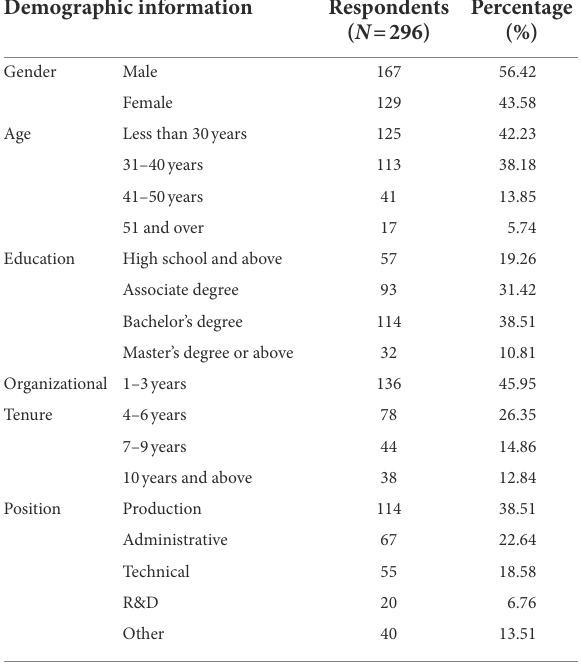
TABLE 1 Descriptive statistics of